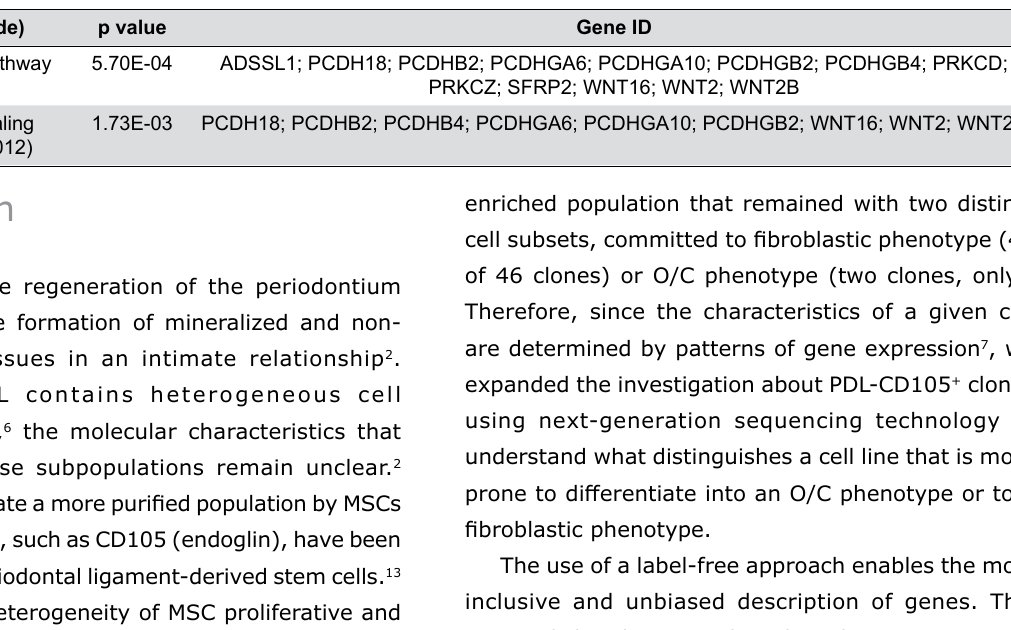
Figure 3 - Heatmap of differentially expressed genes of C-O and C-F clones. Differentially expressed genes (DEG) between C-O and C-F clones were obtained by DESeq and EdgeR packages (R/Bioconductor) with α=5% and |log2FC|≥1. Heatmaps were then generated based on z-score values calculated from FPKMs values of DEG using the heatmap package on R. A total of 235 DEG were observed between C-O and C-F clones. In total, 193 genes were significantly up-regulated in C-O group, and 42 genes were significantly down- regulated in C-O group (up-regulated in C-F) (|log2(fold change)|≥1; p<0.05) Table 2- Significantly overrepresented pathways and respective upregulated genes in C-O